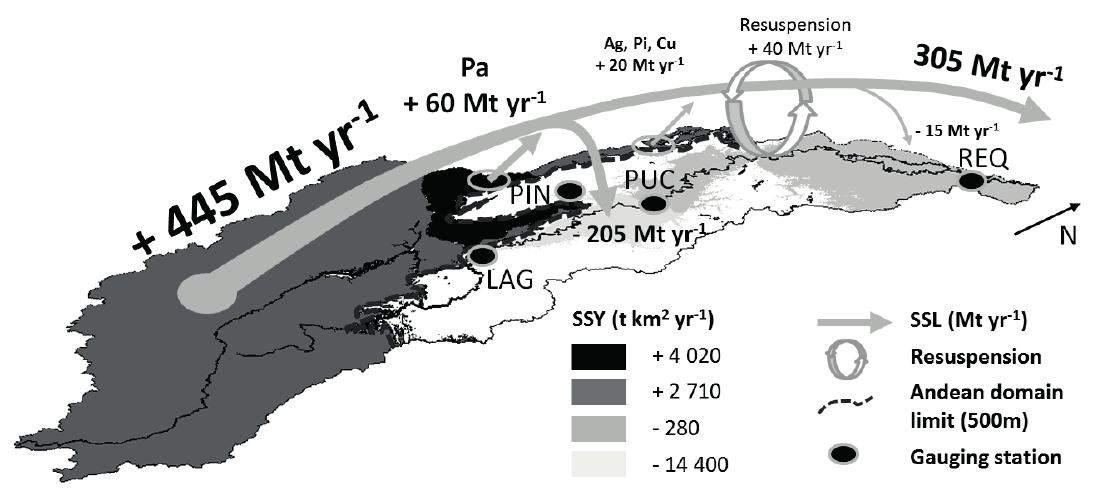
Fig. 3 Spatial distribution of SSY and the sediment budget in the Ucayali River